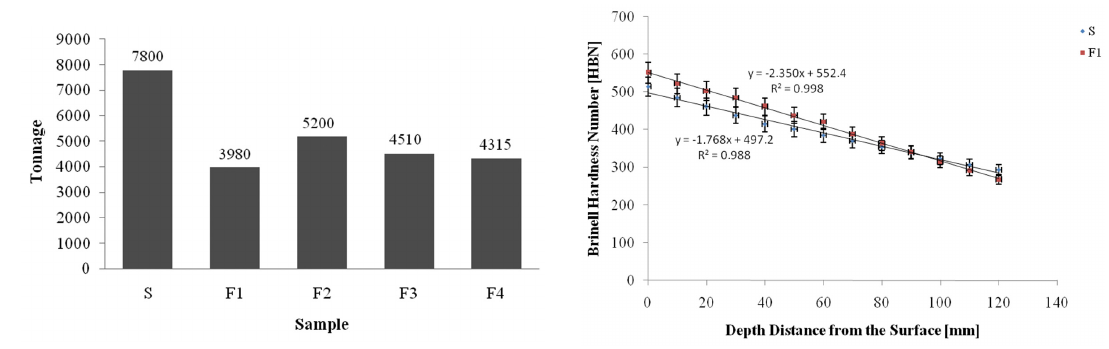
Figure 1. The number of tonnage of rocks crushed before failure. Figure 2. Hardness Value vs Depth for S and Table 1. Results of spectrometric analysis.